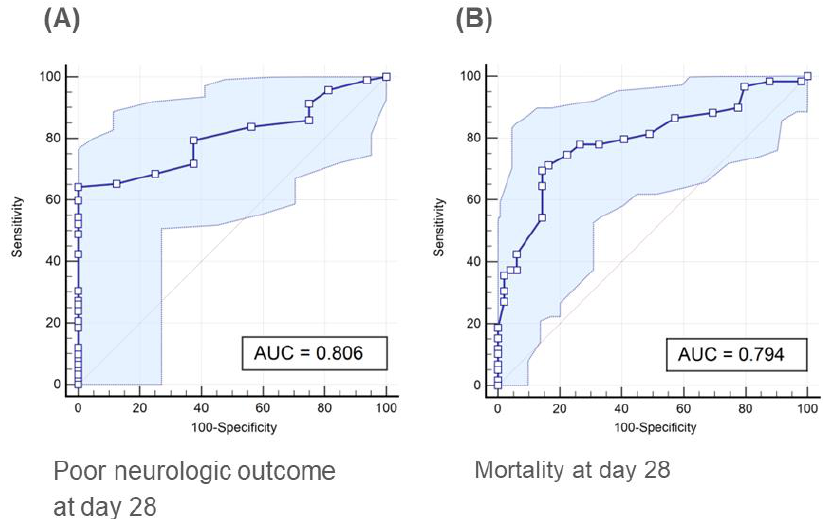
Figure 3. Receiver operating characteristic curves of rCAST score for predicting poor neurologic outcome ( A ) or mortality ( B ) at day 28. Light blue areas represent the 95% confidence interval. AUC: area under the curve.